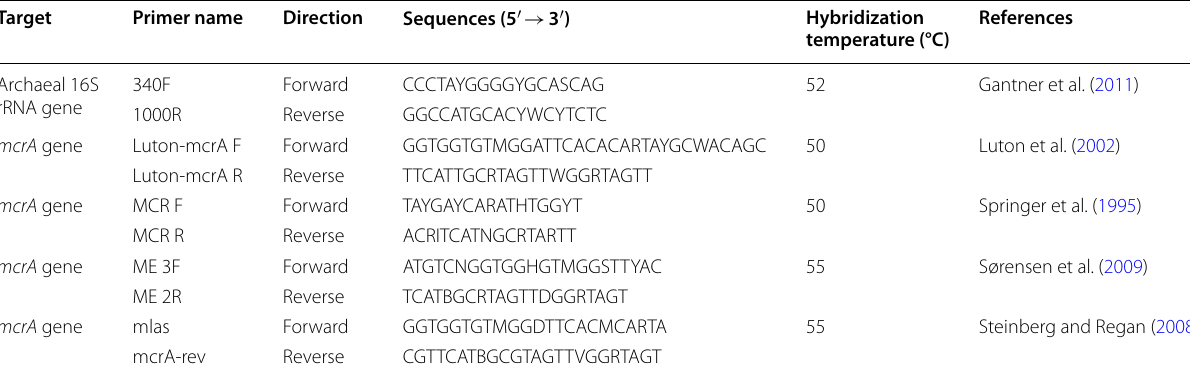
The presence or absence of the PCR product is indicated as ( Table 4 PCR primers for archaeal 16S rRNA and mcrA genes for the present initial